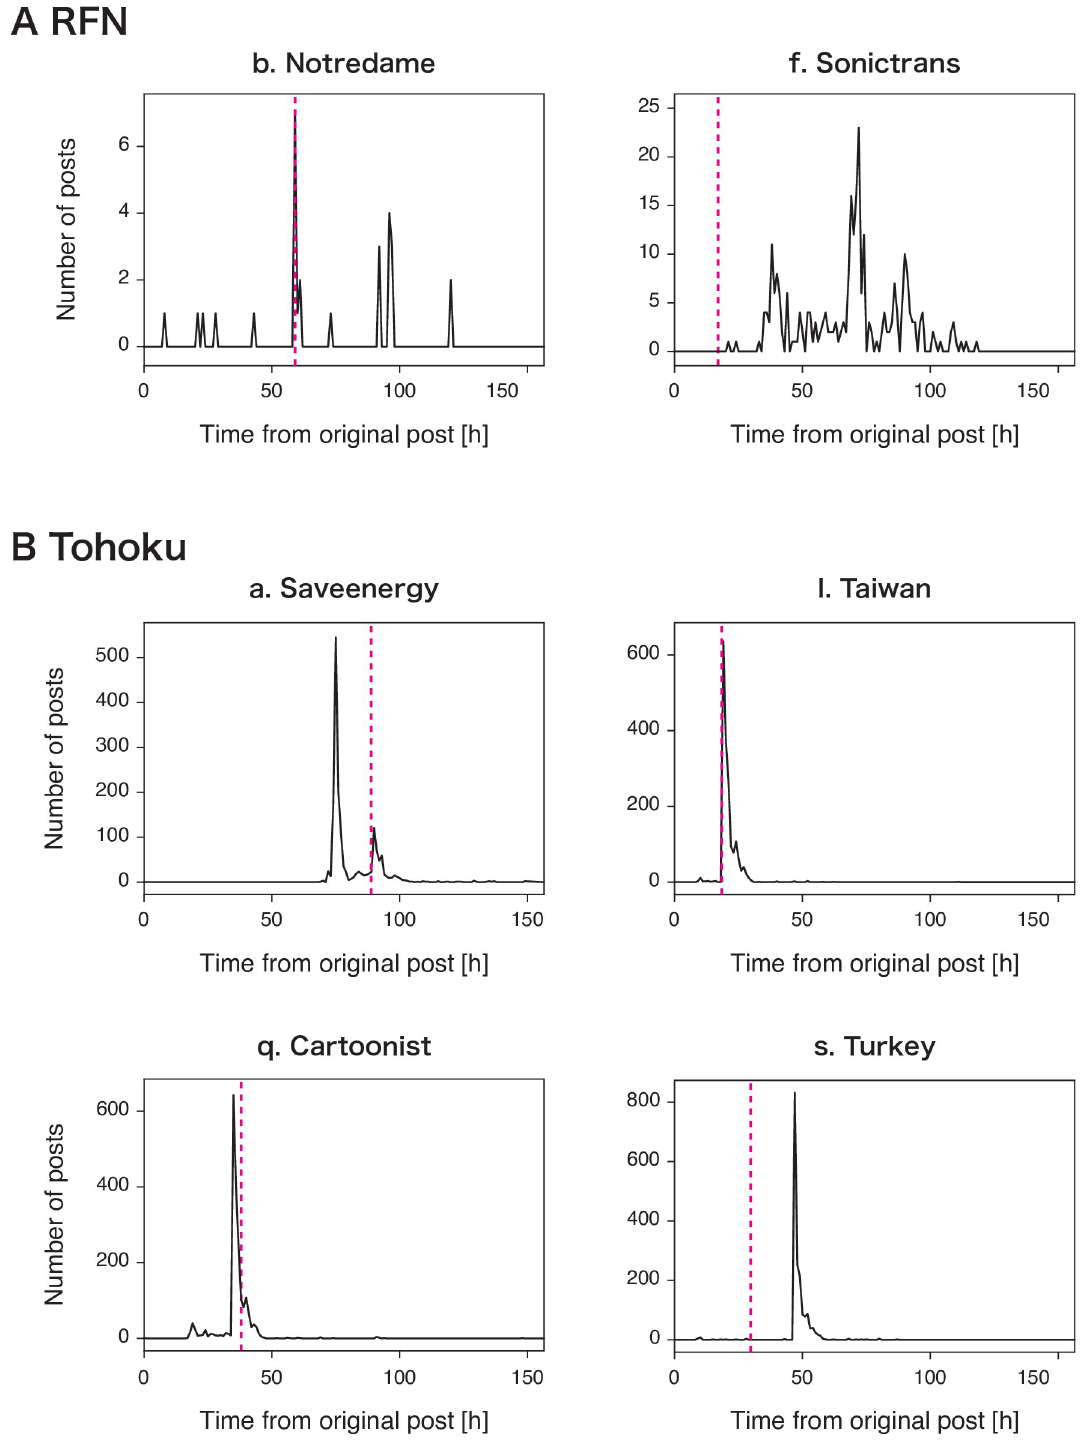
Fig 5. Time series of the fake word frequency for fake news items: (A) RFN and (B) Tohoku datasets. In each panel, the black line represents the time series of the “fake” word count per hour for the tweets related to the fake news item and the magenta vertical lines represent the correction time t c